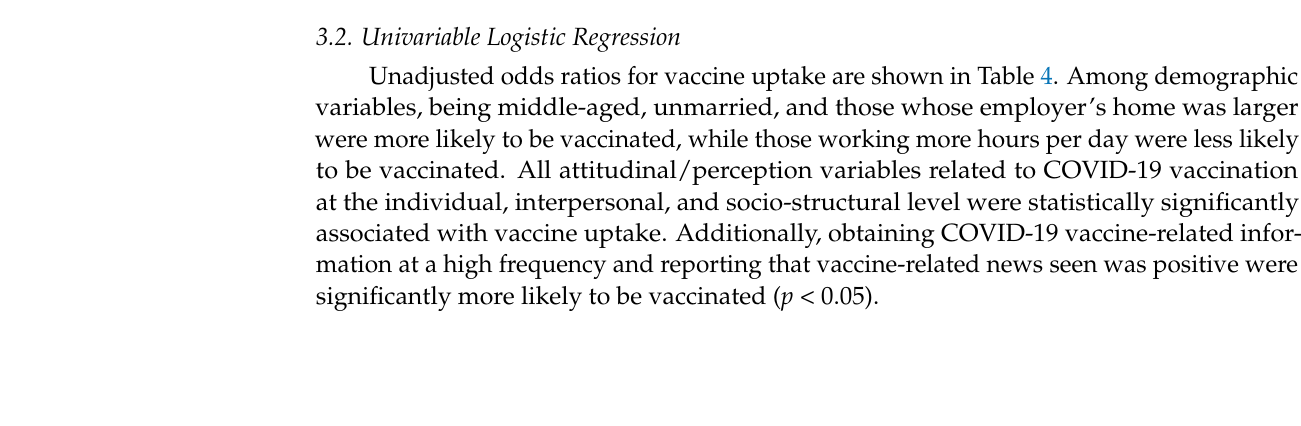
Frequency Vaccinated *